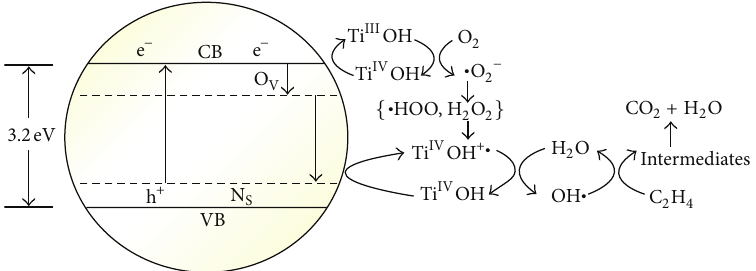
Figure 9: Schematic diagram for the process in the photooxidation of ethylene and electron transfer process over N-TiO 2 under visible light